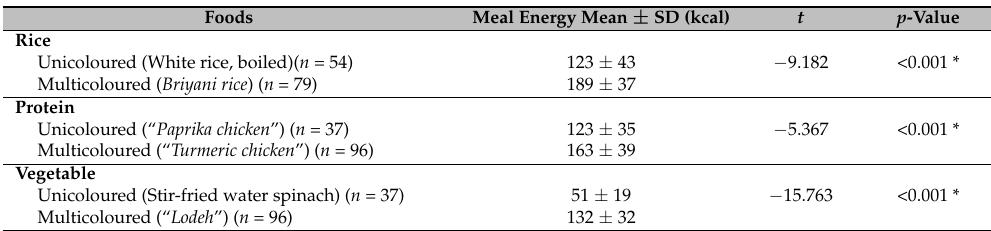
Table 11. Comparison of meal energy of food selection by subjects between unicoloured and multicoloured food ( n = 133)